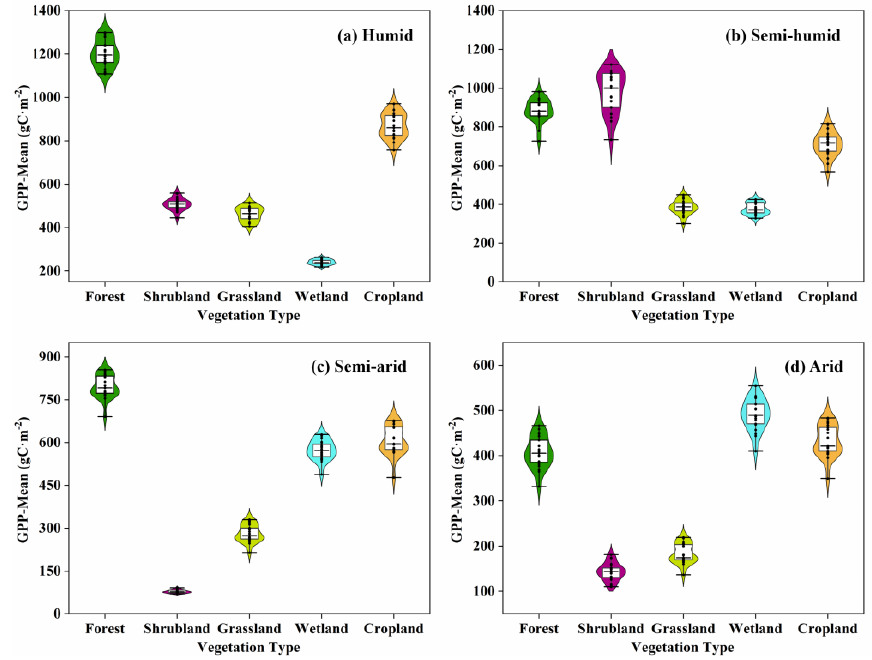
Figure 6. Distribution of GPP for different vegetation types in four arid-humid zones from 2001–2021. ( a – d ) represent the GPP distribution for each vegetation type in the humid, semi-humid, semi-arid, and arid zones. The upper, middle, and lower lines of each violin plot represent the maximum, median and minimum values, the middle rectangle indicates the 25%~75% quantile. The width of the violin plot represents the intensity of the distribution of values.